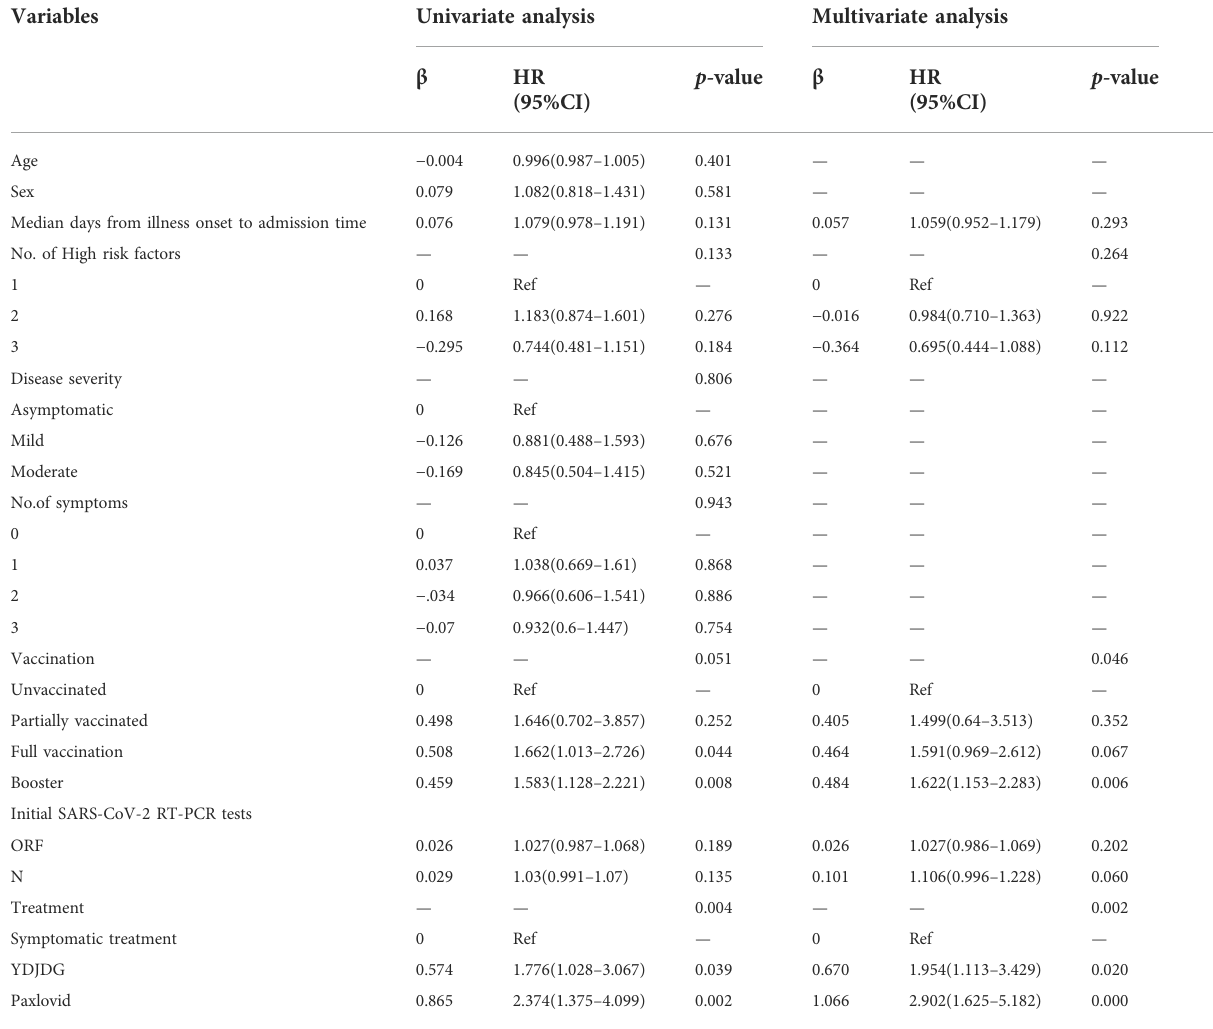
TABLE 1 Univariate and multivariate Cox regression analyses for SARS-CoV-2 nucleic acid shedding after a follow-up of 14